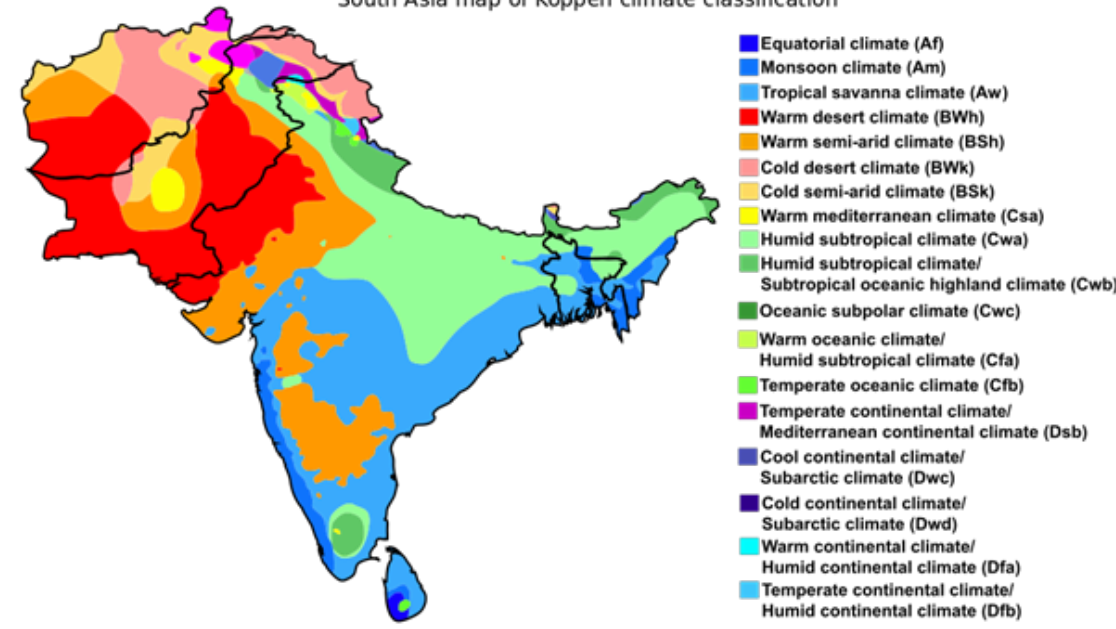
Figure 1A: Köppen Climate Classification of South Asia with equatorial rain forest climate (Af) depicted only in SW Sri Lanka in the whole of South Asia.